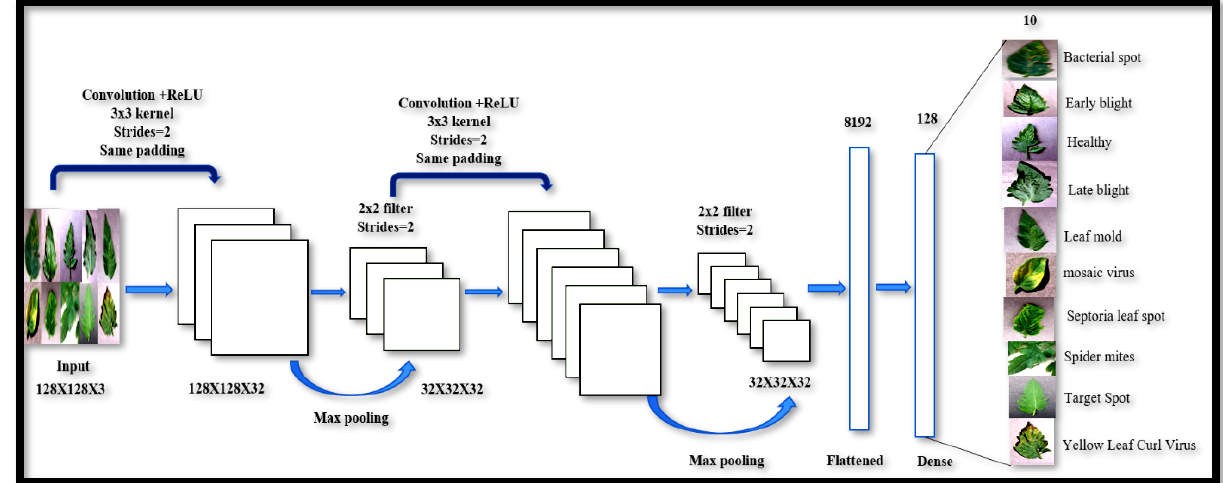
Figure 1. Different class sample images of tomato leaf dataset.